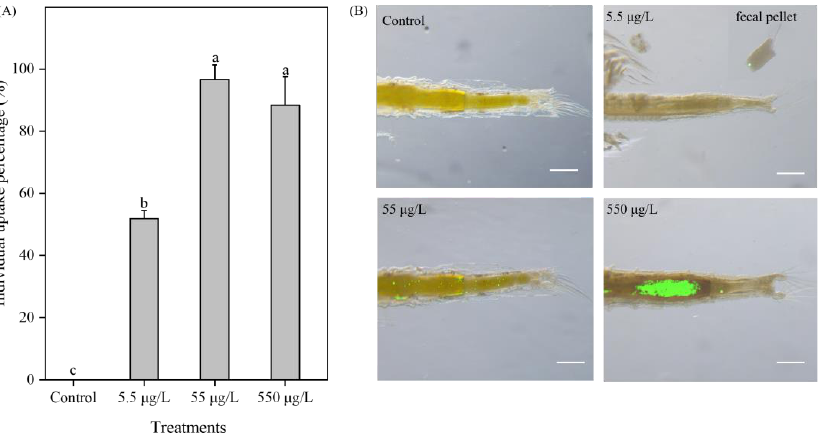
Figure 5. Uptake percentage for A. parthenogenetica exposed to the control and 1 μm PS-NH 2 (5.5, 55, and 550 μg/L) groups for 14 days provided with high food levels ( A ) and images of guts and fecal pellets ( B ). Column bars represent means values ± SD and different letters indicate a significant dif- ference between treatments (one-way ANOVA with Tukey’s post hoc test, p < 0.05). The scale bar is 20 μm.